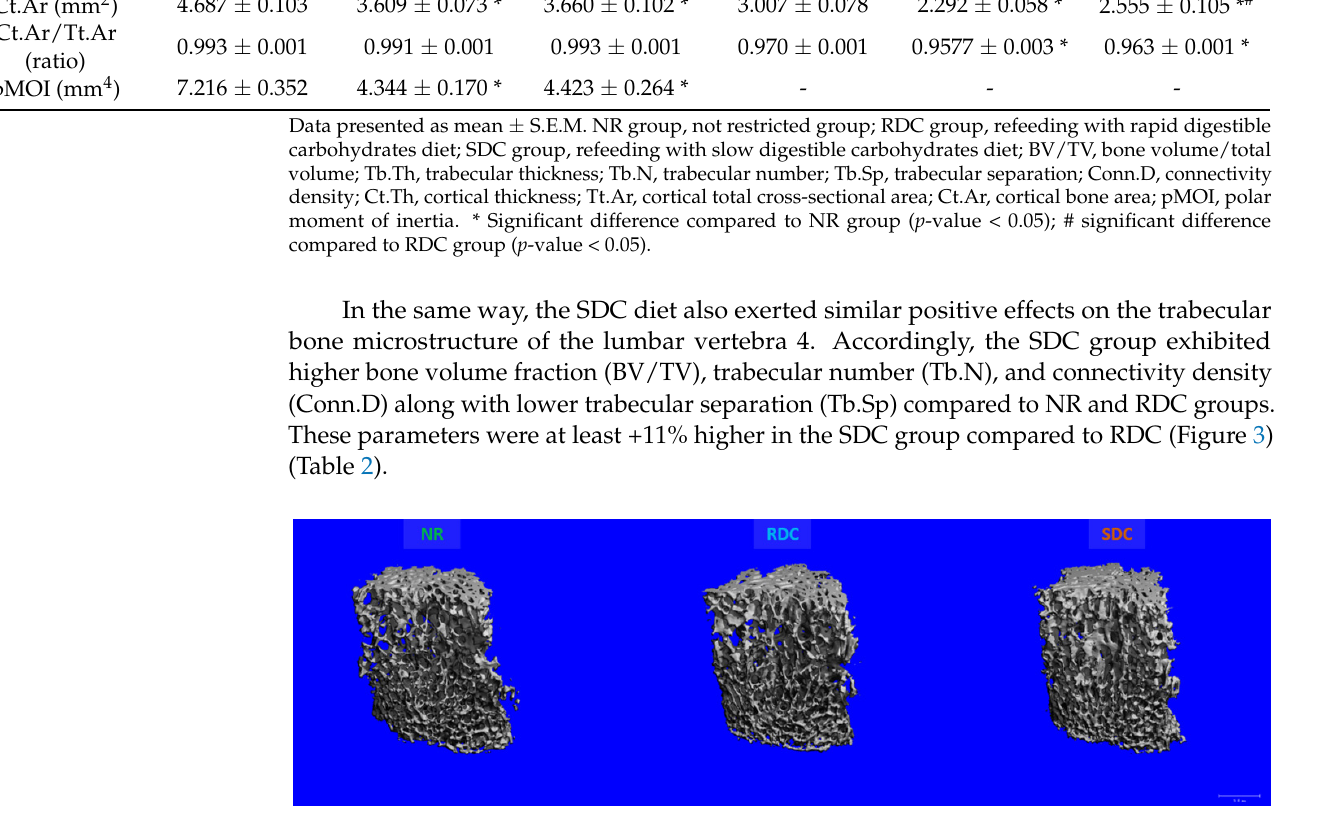
Figure 3. Representative MicroCT images of the vertebra 4 trabecular bone after the refeeding period. NR group, not restricted group; RDC group, refeeding with rapid digestible carbohydrates diet; SDC group, refeeding with slow digestible carbohydrates